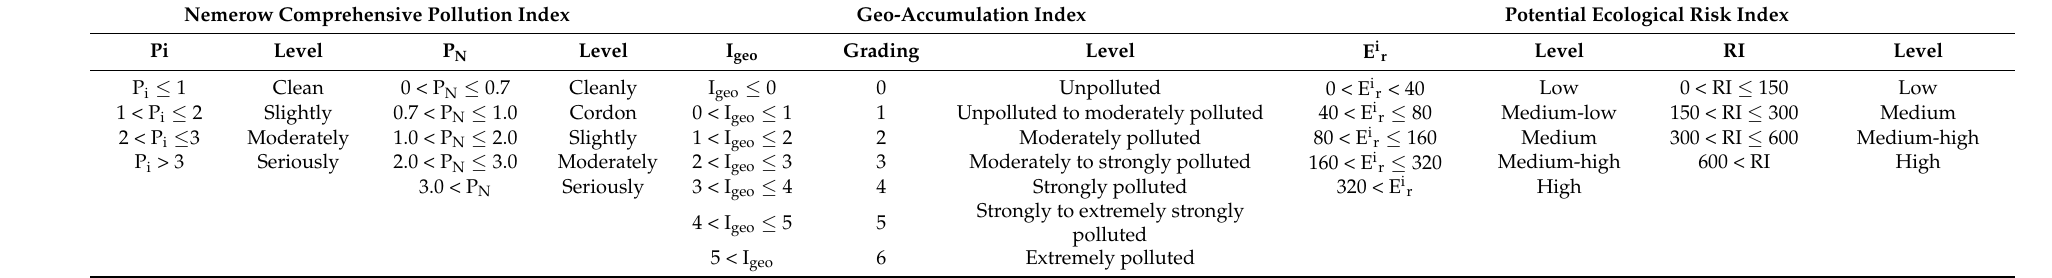
Table 1. Classification criteria of soil metal pollution